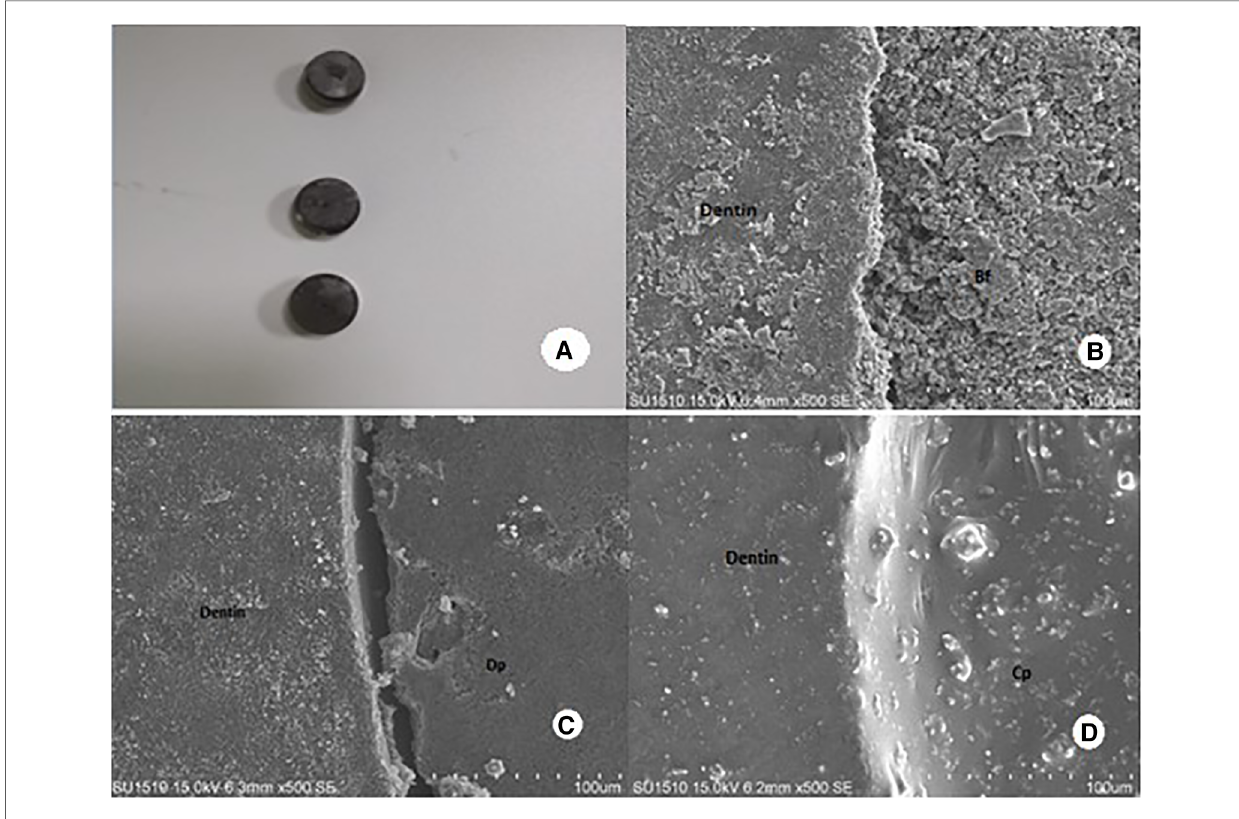
FIGURE 4 SEM images. ( A ) Dentin discs coated with Ag-Pd are randomly selected. ( B – D ) Cohesive failure modes in representative scanning electron micrographs of the root canal sealer-dentin interface after push-out test ( B ) BIOfactor MTA (Bf) ( C ) Diapaste, and ( D ) Calplus (original magni fi cation ×500).